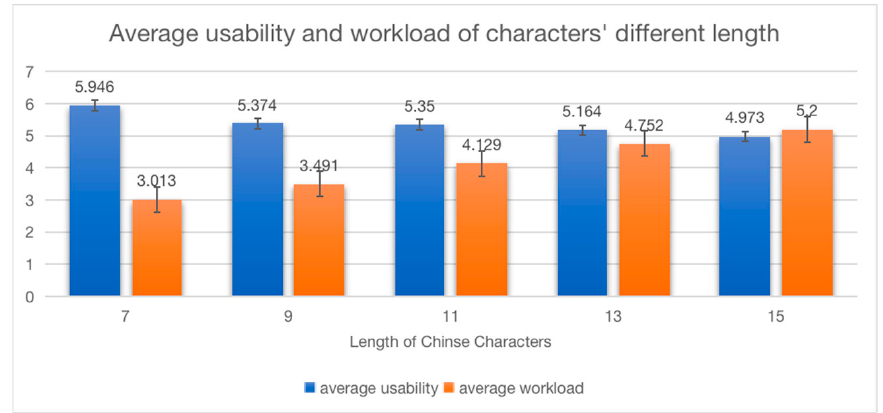
Figure 8. Average usability and workload of Chinese characters’ length.